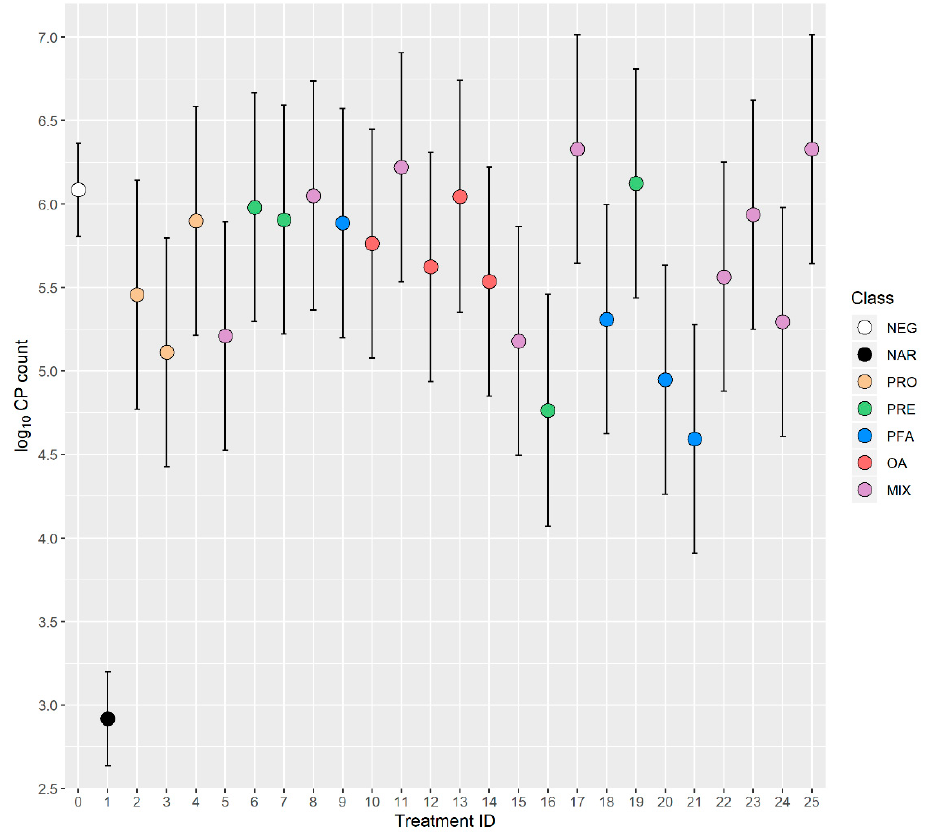
Figure 1. Cecal Clostridium perfringens (CP) counts with 95% confidence intervals. Negative control (NEG) is treatment 0, narasin (NAR) is treatment 1, probiotics (PRO) are treatments 2–4, prebiotics (PRE) are treatments 6, 7, 16 and 19, phytogenics (PFA) are treatments 9, 18, 20 and 21, organic acids (OA) are treatments 10, 12, 13 and 14, and mixed products (MIX) are treatments 5, 8, 11, 15, 17 and 22–25.